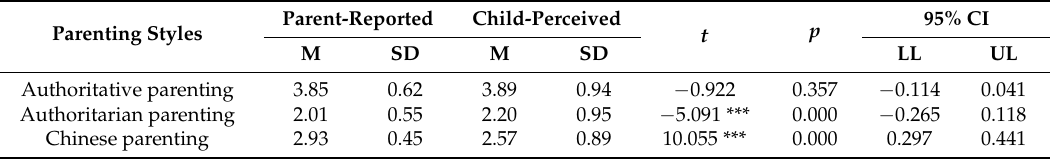
Table 4. Differences between parent-reported and child-perceived parenting across all parenting